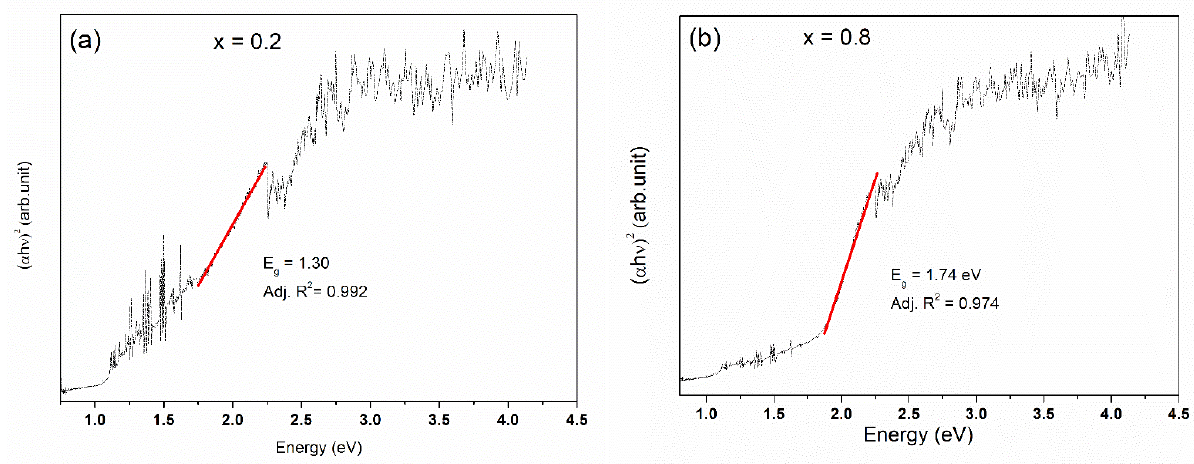
Figure 6. Plot of ( α h ν ) 2 against photon energy (h ν ) for samples ( a ) Cu 2 ZnSn 0.8 Si 0.2 Se 4 and ( b ) Cu 2 ZnSn 0.2 Si 0.8 Se 4 . The Eg values for Cu 2 Zn(Sn 0.8 Si 0.2 )Se 4 and Cu 2 Zn(Sn 0.2 Si 0.8 )Se 4 were 1.30 and 1.74 eV,